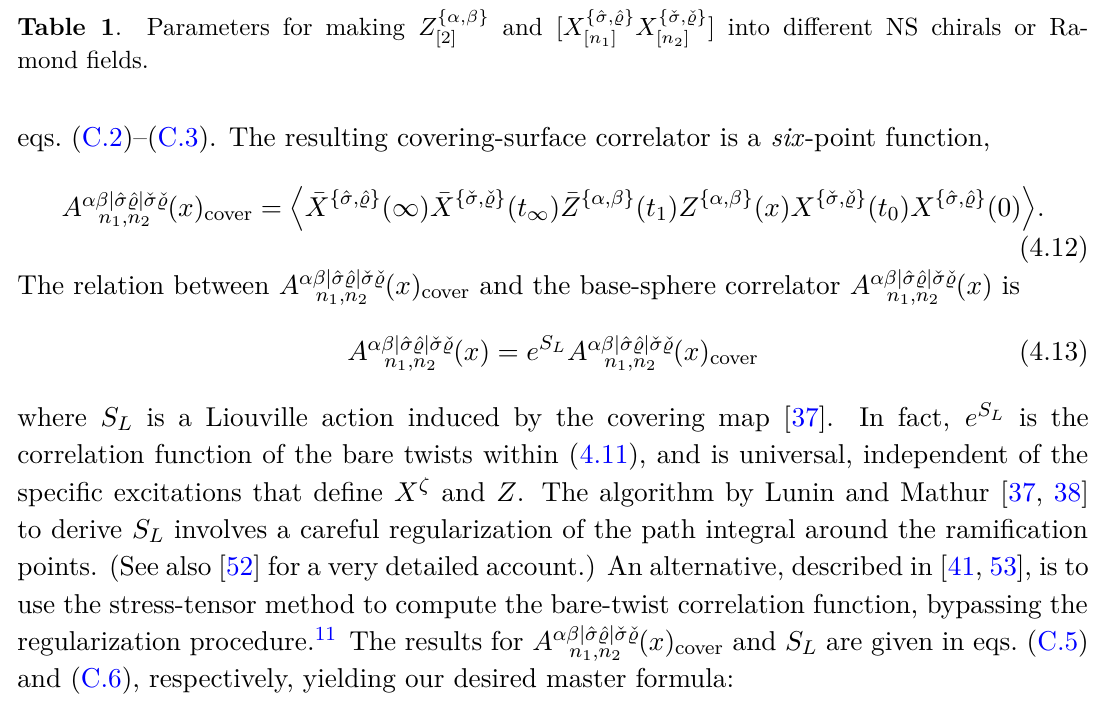
and [ X { ˆ σ, ˆ % } X { ˇ σ, ˇ % } ] into different NS chirals or Ra- [2] [ n 1 ] [ n 2 ]